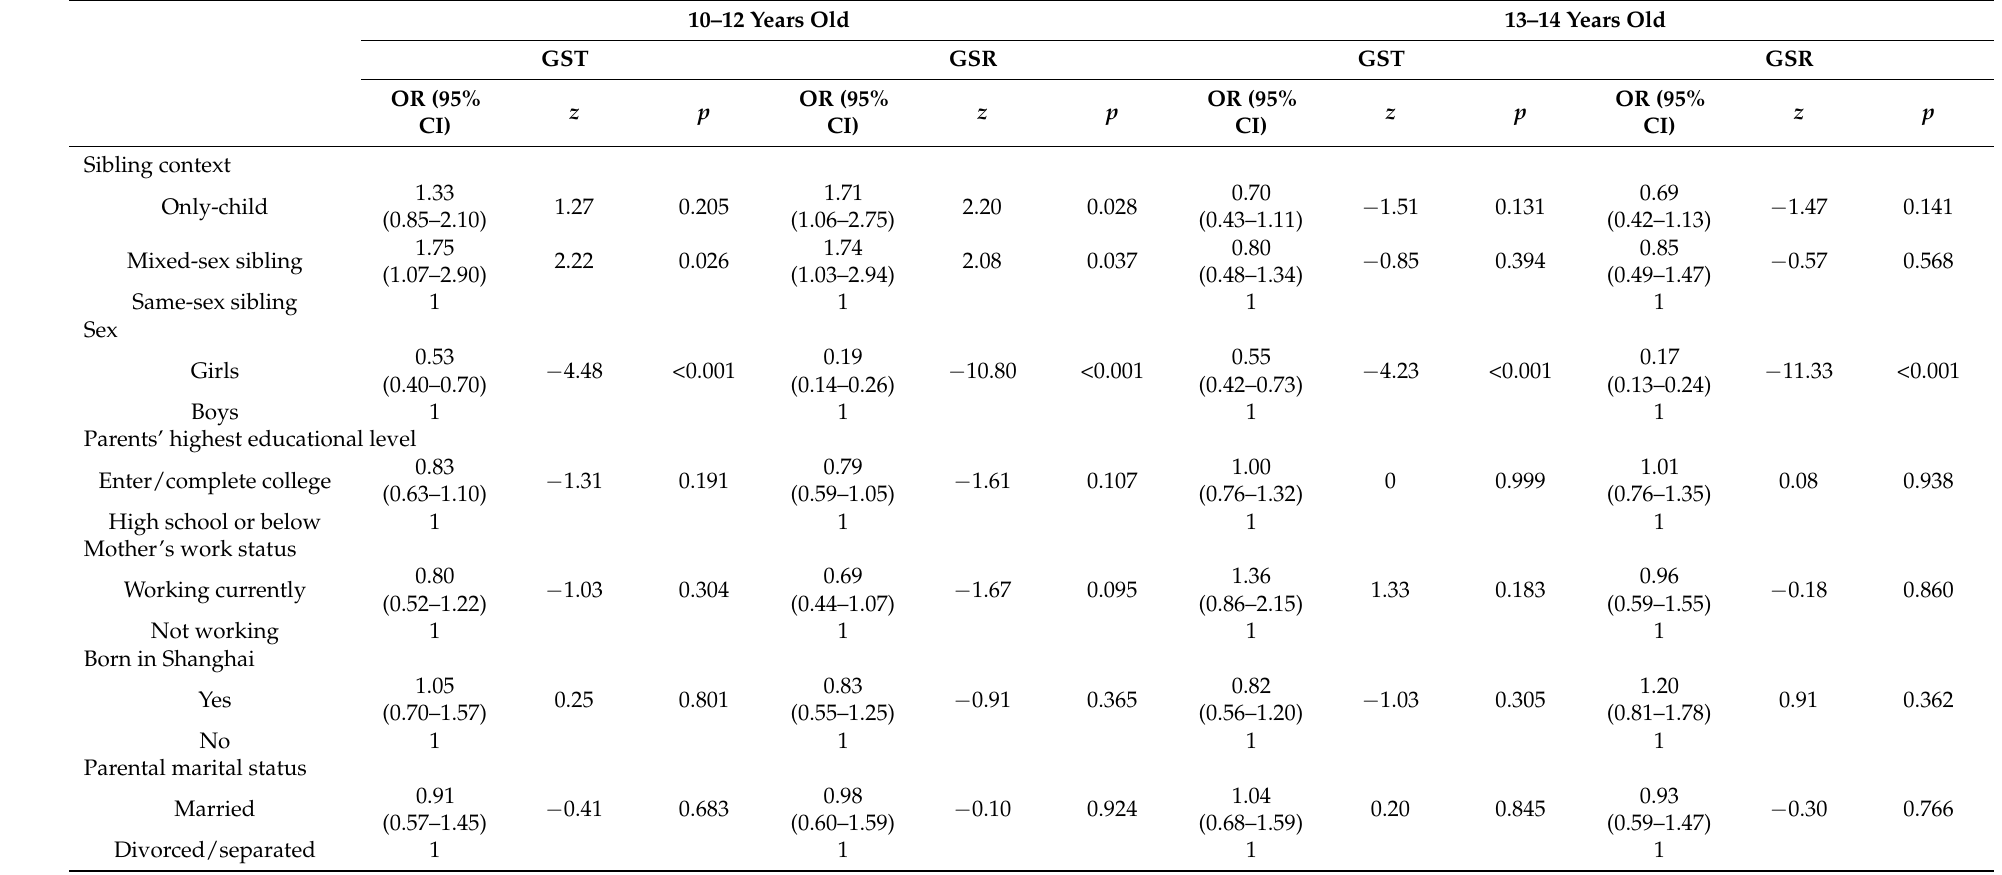
Table 4. Ordinal logistic regression testing sibling context on two gender norm scales’ scores, stratified by age